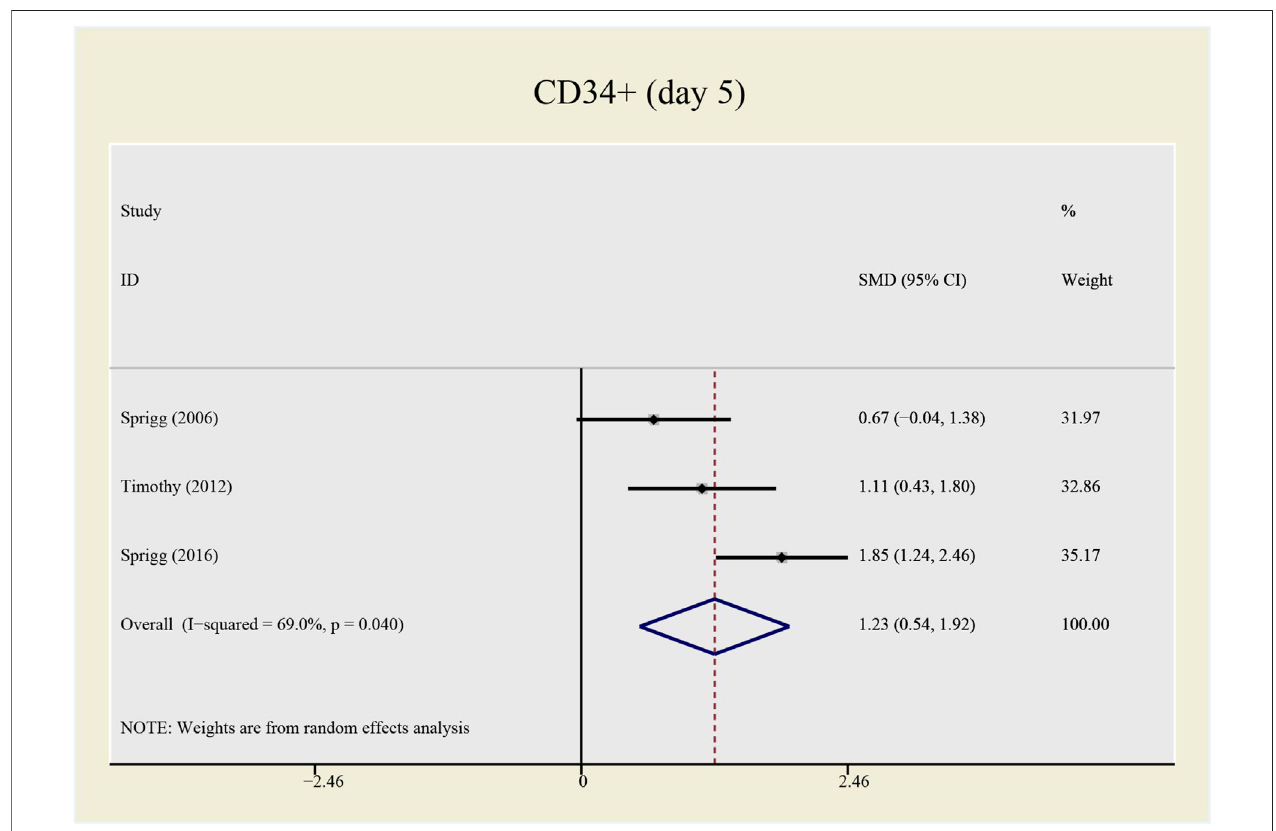
FIGURE 7 | Forrest plot for CD34 + at day